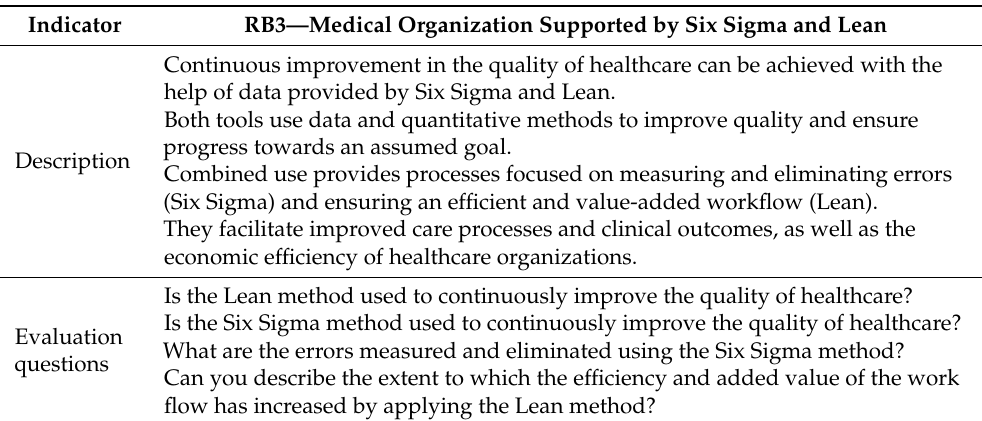
Table A17. The indicator RB3—Medical organization supported by Six Sigma and Lean.